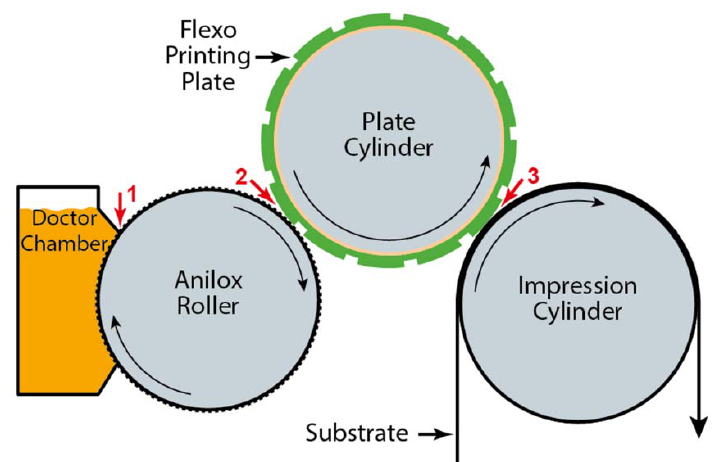
Figure 2. Printing pressure adjustment points in the flexo inking system.